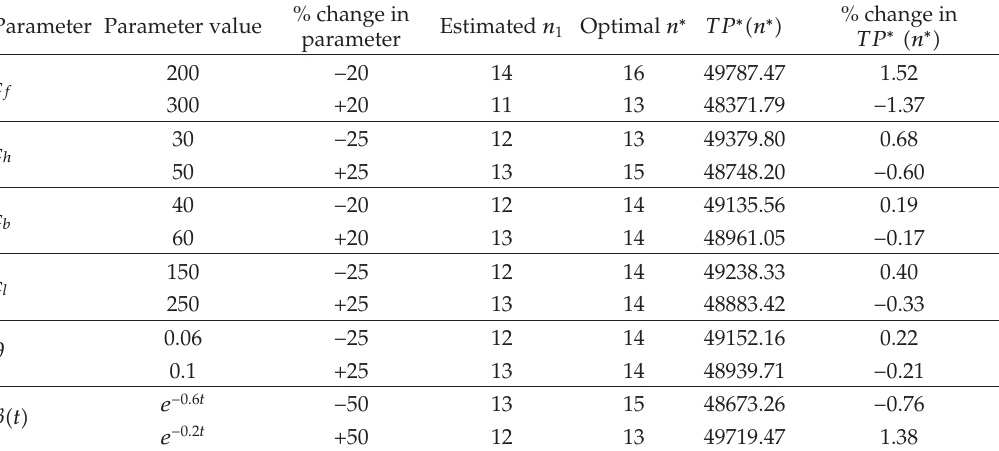
Table 3: Sensitivity analysis on parameters changed for Example